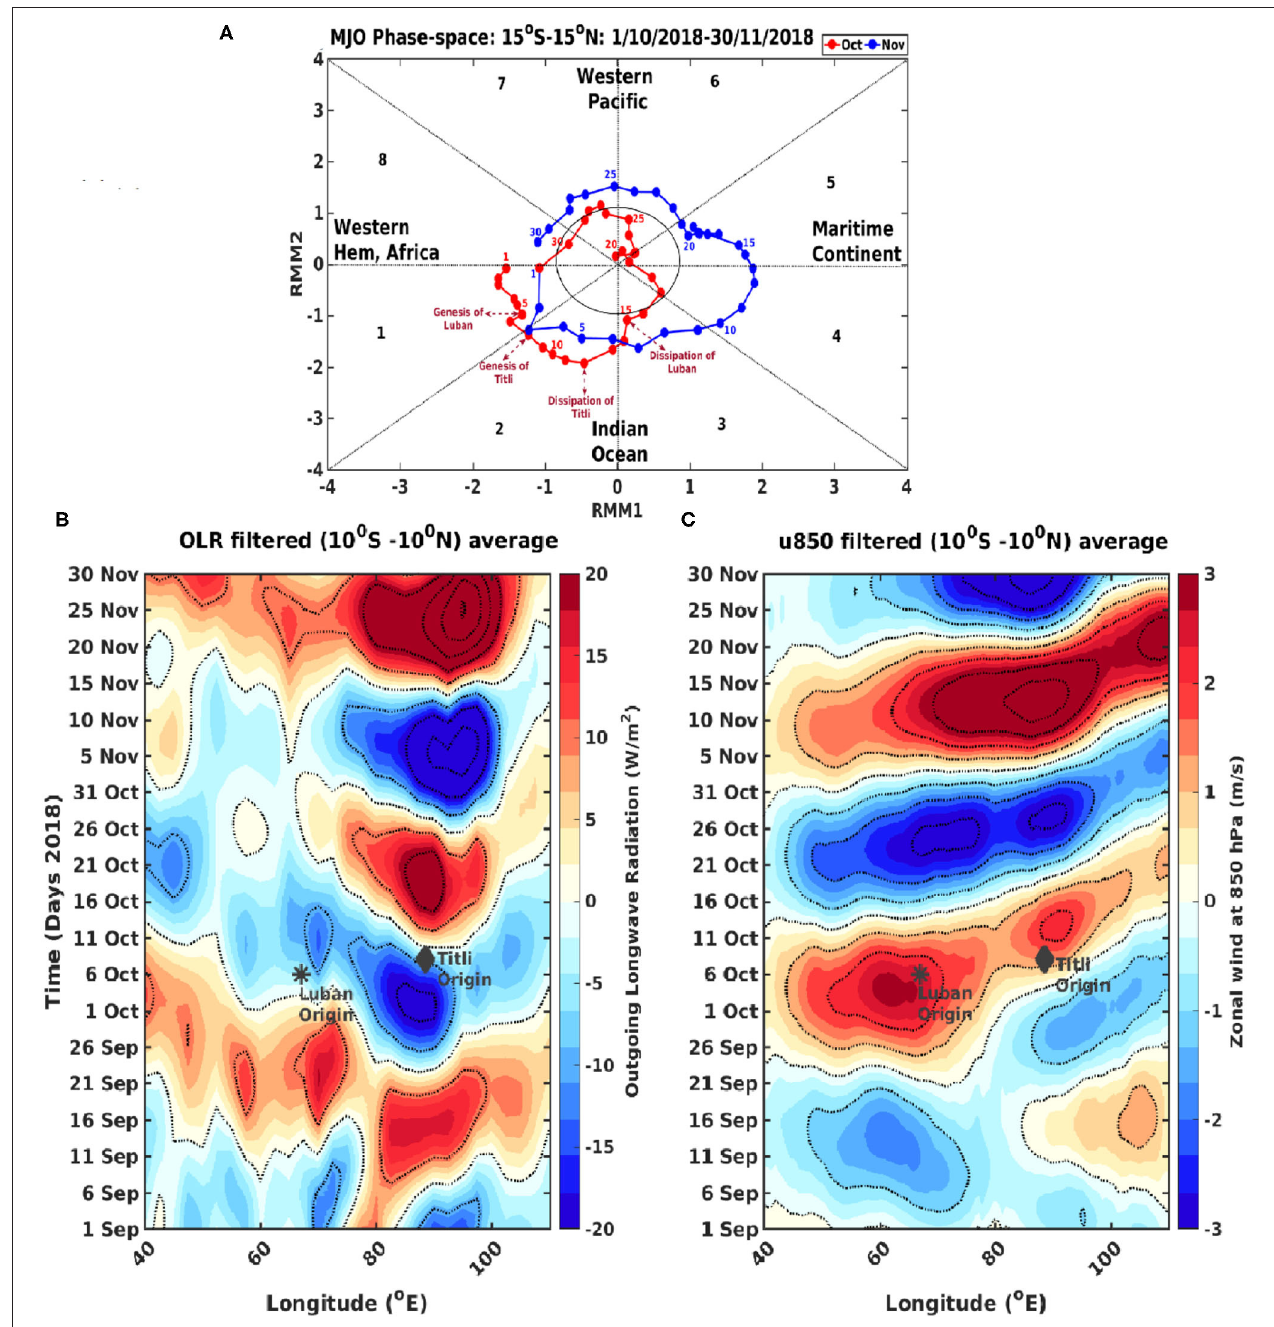
FIGURE 13 | (A) A phase diagram of the Madden-Julian oscillation (MJO) from September 1 to November 30, 2018. The red and blue colors denote the propagation in October and November, respectively. MJO activity is weak (strong) when the index is within (outside) the circle, (B) a time-longitude Hovmöller diagram of 30- to 90-day band-pass-filtered outgoing longwave radiation (W/m 2 ), and (C) zonal wind (m/s) at 850 hPa (C) , averaged over 10 ◦ S to 10 ◦ N from September 1 to November 30, 2018. Black asterisk and diamond symbols show the origin of cyclones Luban and Titli, respectively.